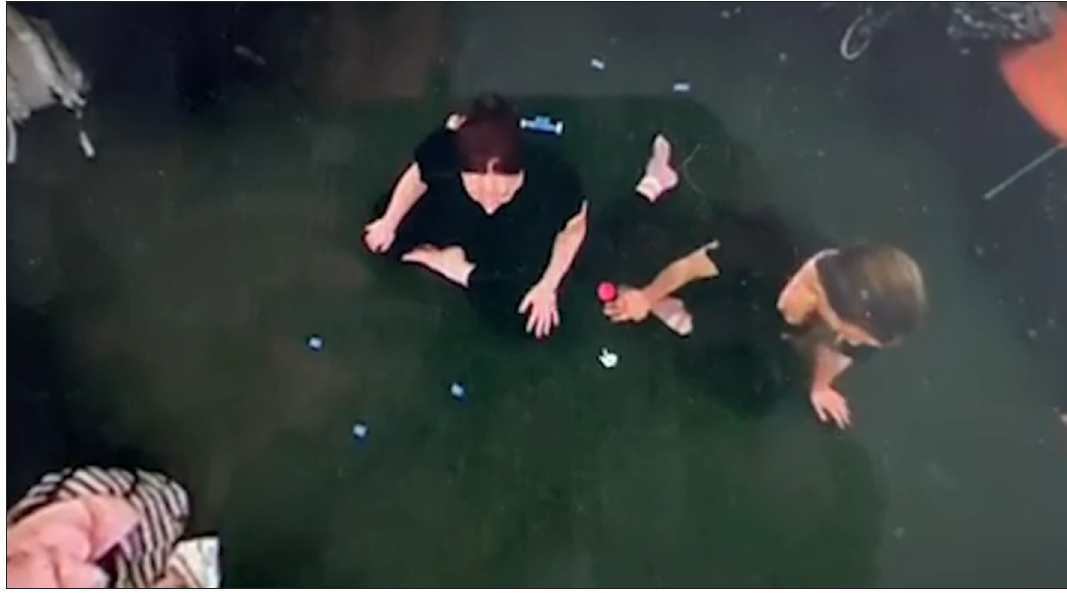
Figure 3: God’s-eye